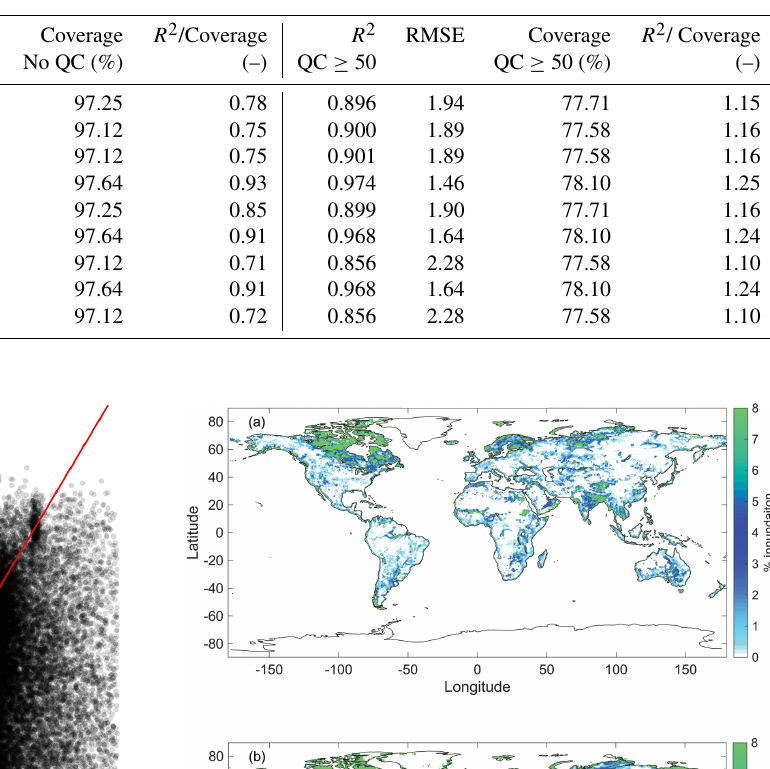
Table 1. Model validation results. QC: quality control; RMSE: root mean squared error.